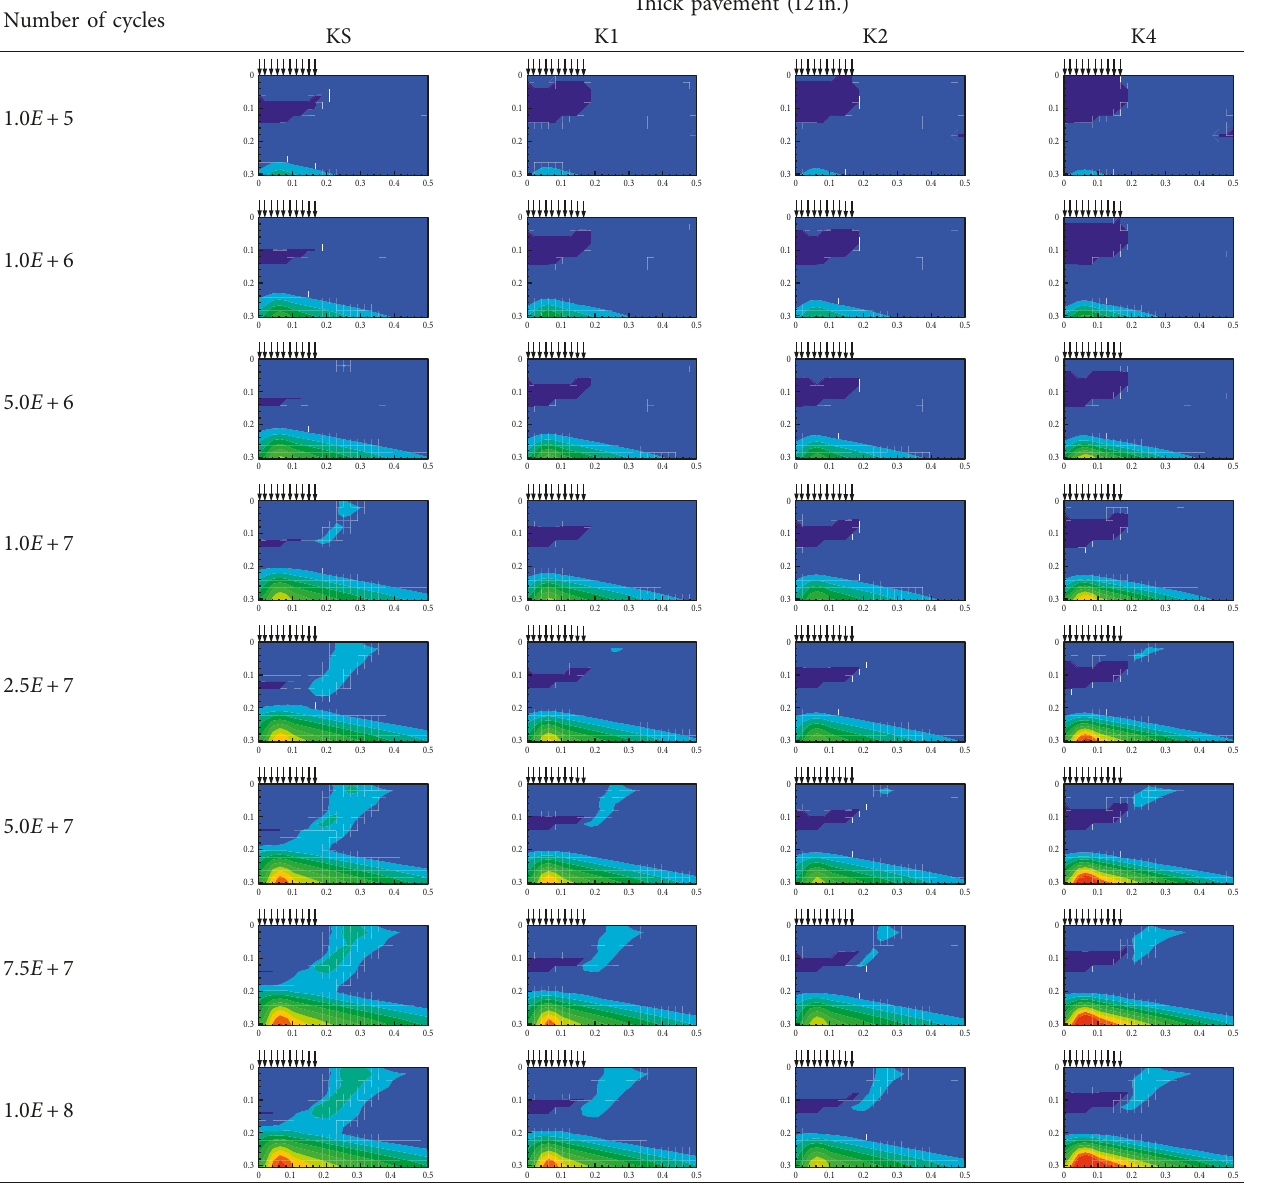
Table 9: Modified contour plots of C for thick pavements in color mode. Thick pavement Number of cycles